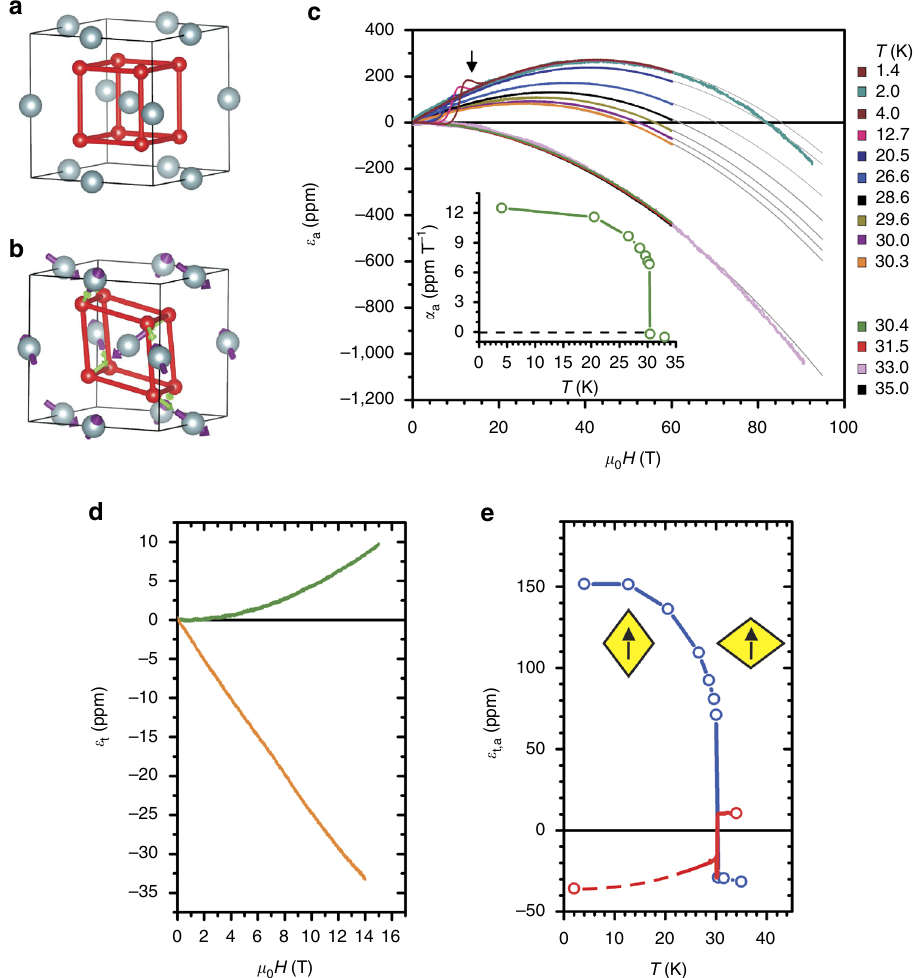
Fig. 1 Axial and transverse magnetostriction in UO 2 . a fcc unit cell of UO 2 . b The low-temperature antiferromagnetic state displaying the transverse 3- k T A magnetic order ( violet arrows ) and oxygen displacements ( green arrows , not to scale) along the 111 h i directions. c Isothermal axial strain ε a vs. H parallel to [111] measured in pulsed magnetic fi elds to 92.5T at different temperatures listed on the right-hand side . Grey lines are fi ts to the expression α a H + β a H 2 . The jump between the curves for 30.3 and 30.4K is a consequence of the fi rst-order phase transition. Linear magnetoelastic coef fi cient α a ( T ) vs. T ( inset ). d Isothermal transverse strain ε t vs. H parallel to [111] at T = 2 K ( orange ) and 34K ( green ). e ε a ( H = 15 T) ( blue ) and ε t ( H = 15T) ( red ) vs. T . This panel shows a fi eld-induced broken fcc symmetry with a different Poisson ratio and an inverted sign in the PM and AFM phases, a consequence of the strong linear term α ( T ). This is also visualized by yellow rhombuses in the fi gure. Arrows mark the direction of applied magnetic fi eld. The axial magnetostriction was also measured in the paramagnetic state on a different sample with H parallel to [100], not shown, and found to follow an H 2 fi eld dependence with a magnitude ~5× smaller than along [111]. Indications of irreversibility were found in the magnetostriction data in the AFM state, indicated with an arrow in